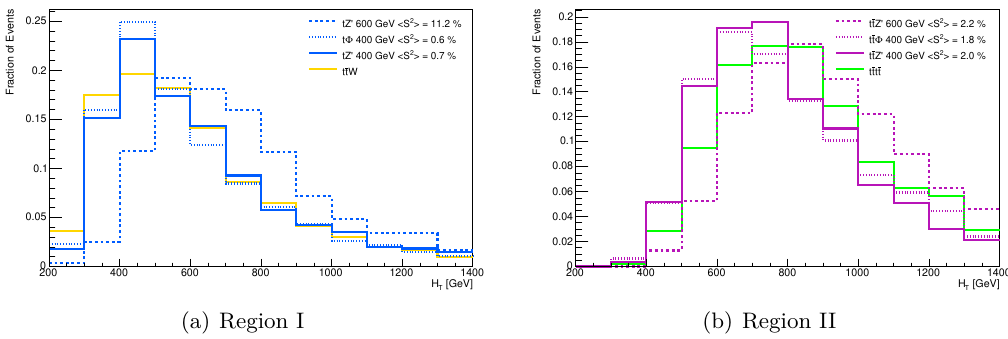
Figure 12 . H T fraction of events for both signal-enriched regions. As it can be seen, the 600 GeV BSM H distribution has a separation an order of magnitude larger than the 400 GeV BSM scenarios T for Region I, whereas for Region II all BSM scenarios are hardly distinguishable from